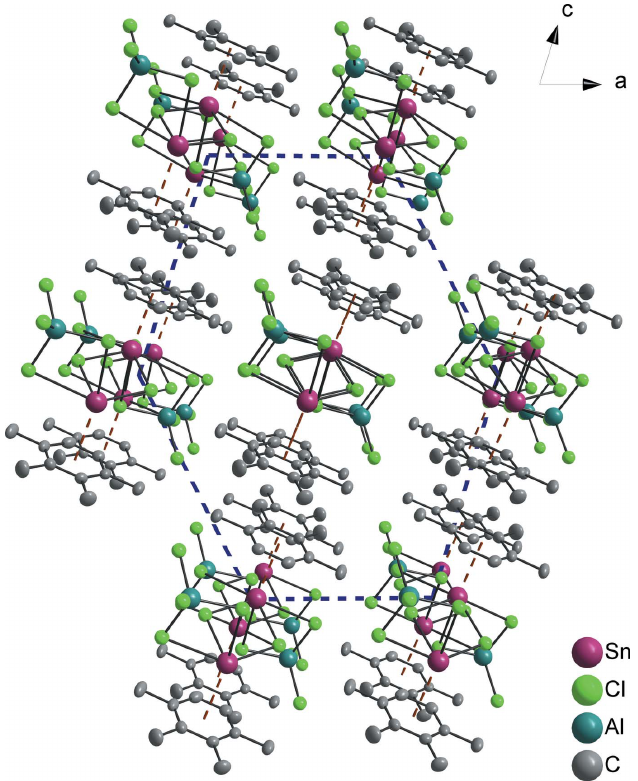
Figure 4 Distorted hexagonal packing of chains in the crystal of 1 (view direction [010]). The most characteristic feature is the parallel orientation of the planes of neighbouring prehnitene ligands in the [001]